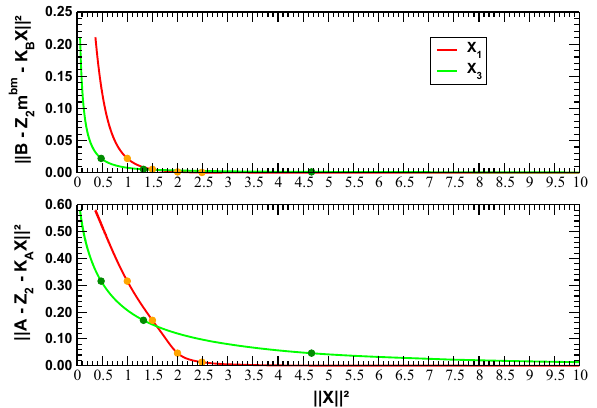
Fig. 25 Relative error for the DSE associated to the highlighted solu- tions of the Dyson–Schwinger equations for X 0 = 1